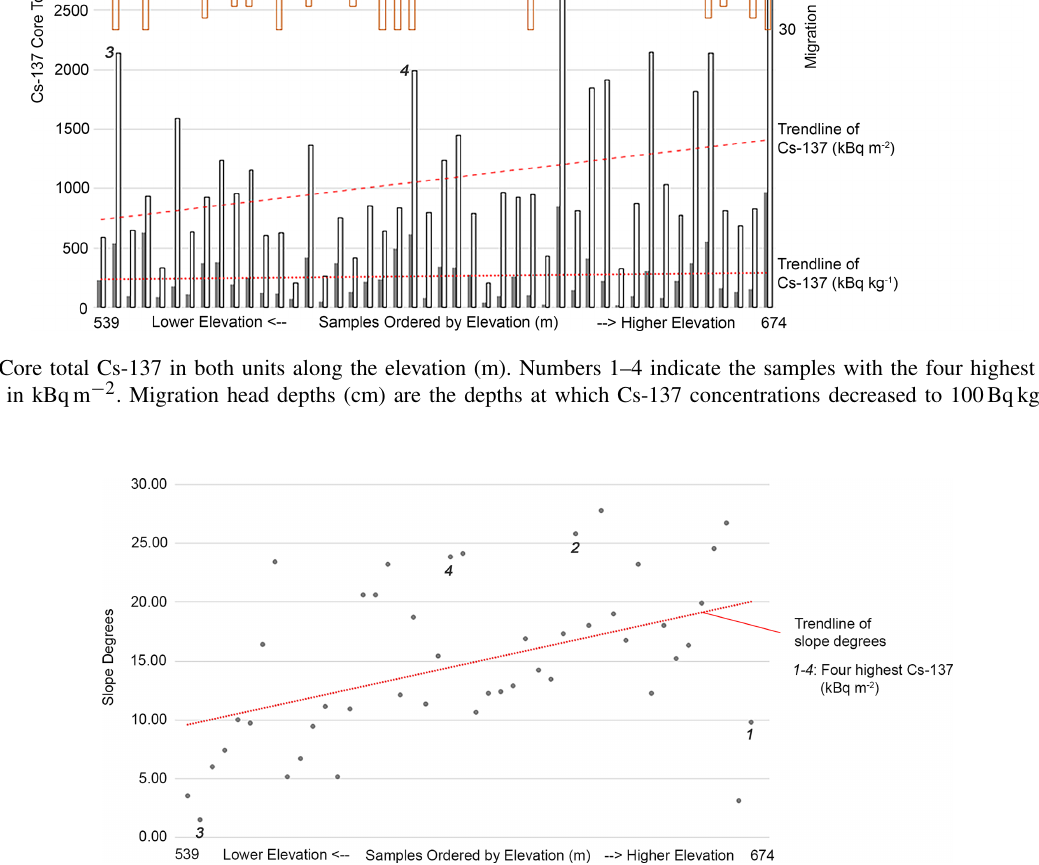
Figure 8. Slope (degrees) of sampling points along the elevation (m). The numbers 1–4 correspond to the same numbers in Fig. 7.